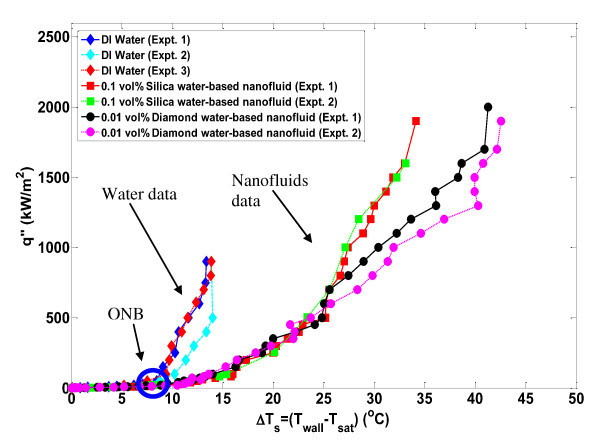
Pool boiling curve for DI water and nanofluids tests systematically discussed in this work. Approximate uncertainty in measurement of q" and ΔTs are both 2%. The ONB is at approximately the same superheat (~7°C) for all experiments (i.e., water and nanofluid ONB is very similar). ONB, onset of nucleate boiling.